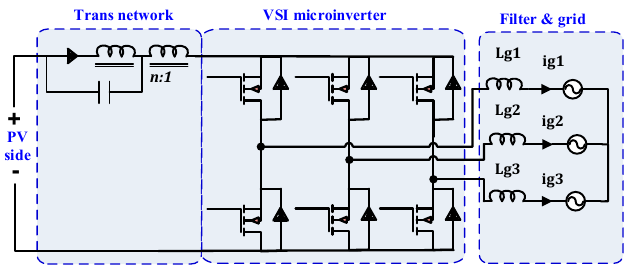
Figure 14. Structure of transformer trans-ZSI topology [102].